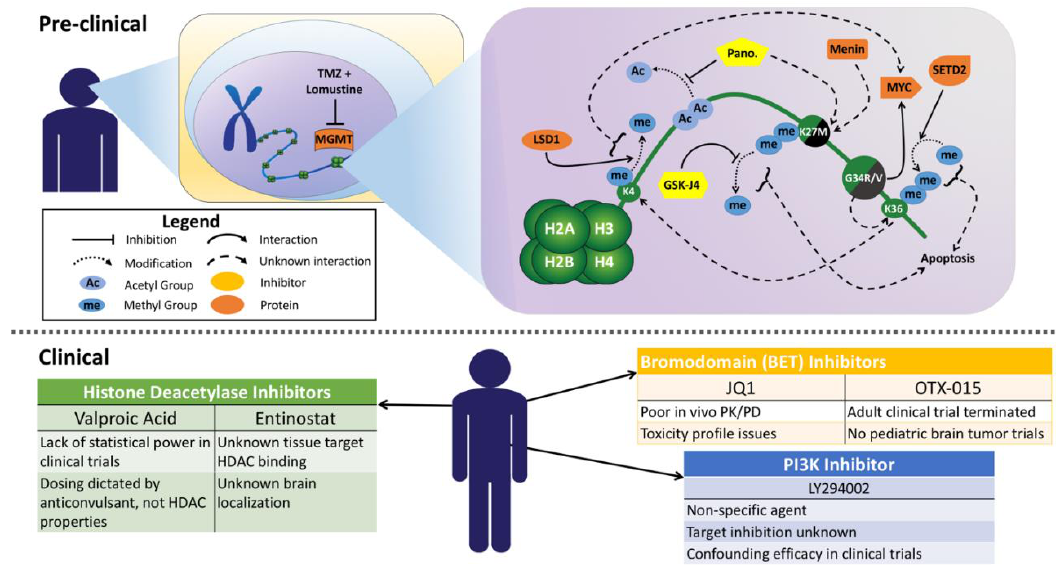
Figure 1. Unexplored pre-clinical molecular interactions and inconclusive clinical data in pediatric high-grade glioma research and trials. Temozolomide (TMZ), O-6-methylguanine-DNA methyltransferase (MGMT), lysine-specific demethylase 1 (LSD1), Pano, MYC, GSK-J4, JQ1, PK/PD, OTX-015, PI3K.